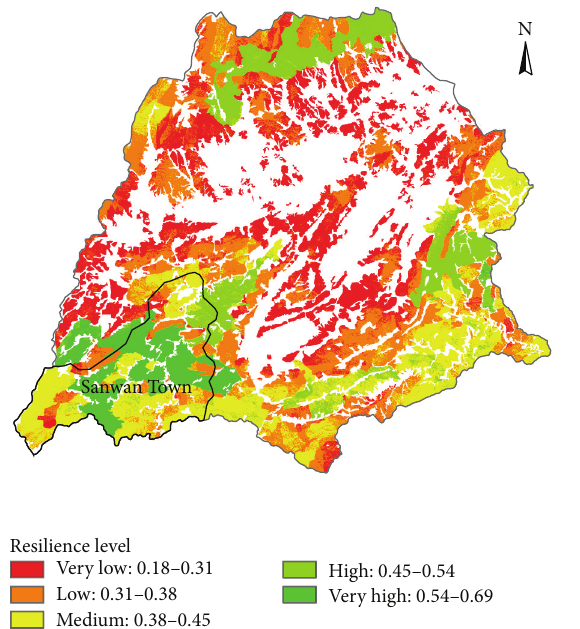
Figure 2: Spatial pattern of the forest ecosystem resilience level in Yongxin County and the location of Sanwan Town where Sanwan National Forest Park is located.